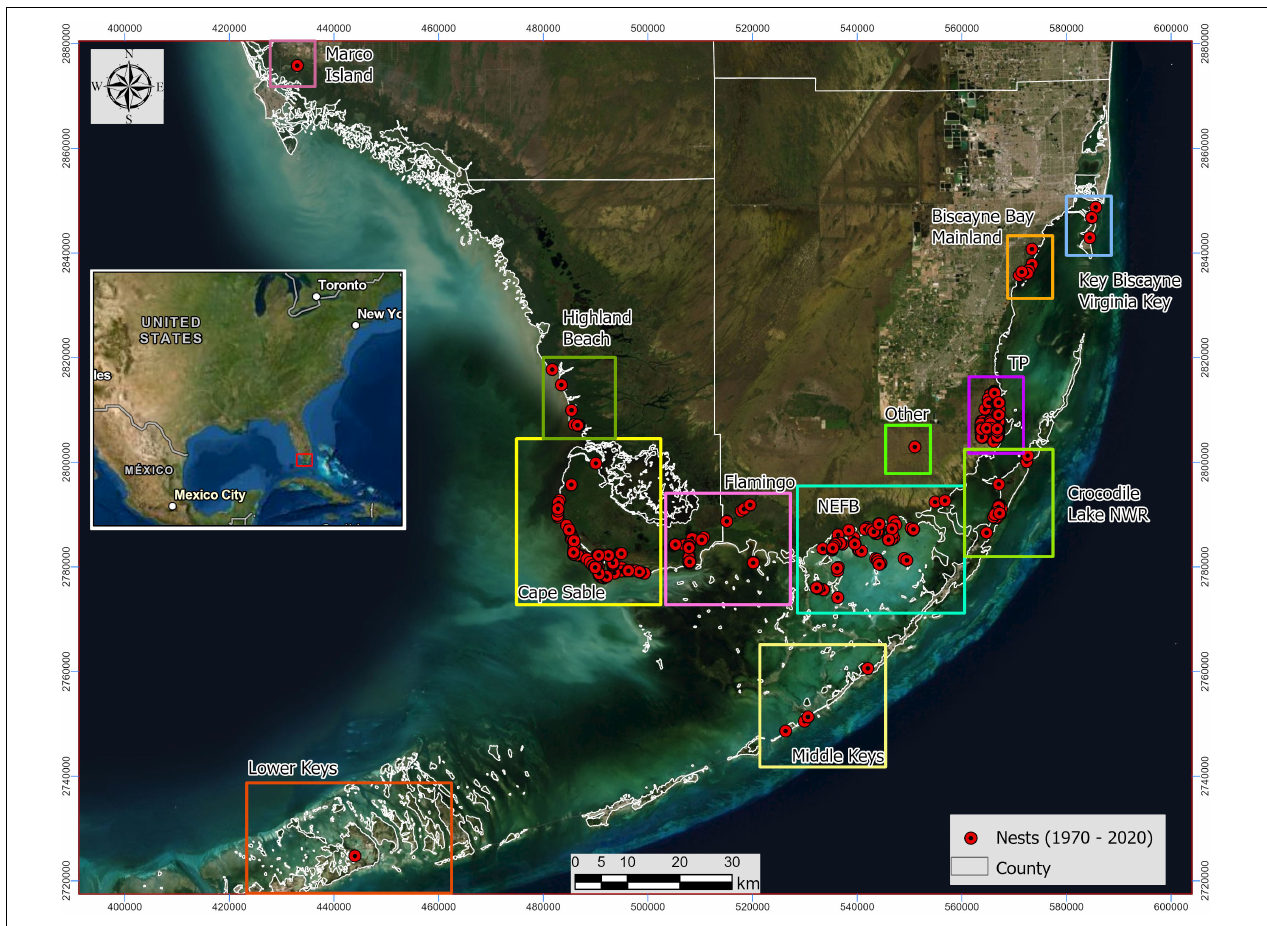
FIGURE 1 | Main nesting areas of American crocodiles ( Crocodylus acutus ) identified from 1970 through 2020 across South Florida, United States. The “Other” area refers to C-110 and MM113 Overseas Highway Southbound. Notice the most historically representative areas are within the Everglades National Park (ENP; Cape Sable, Flamingo, and Northeast Florida Bay –NEFB), Crocodile Lake National Wildlife Refuge (NWR), and Turkey Point Power Plant (TP)). However, areas around the Keys, the western coast (Marco Island and Broad River) and the eastern part of South Florida (Biscayne Bay and Virginia Key) are also nesting areas used by American crocodiles across this 50-year